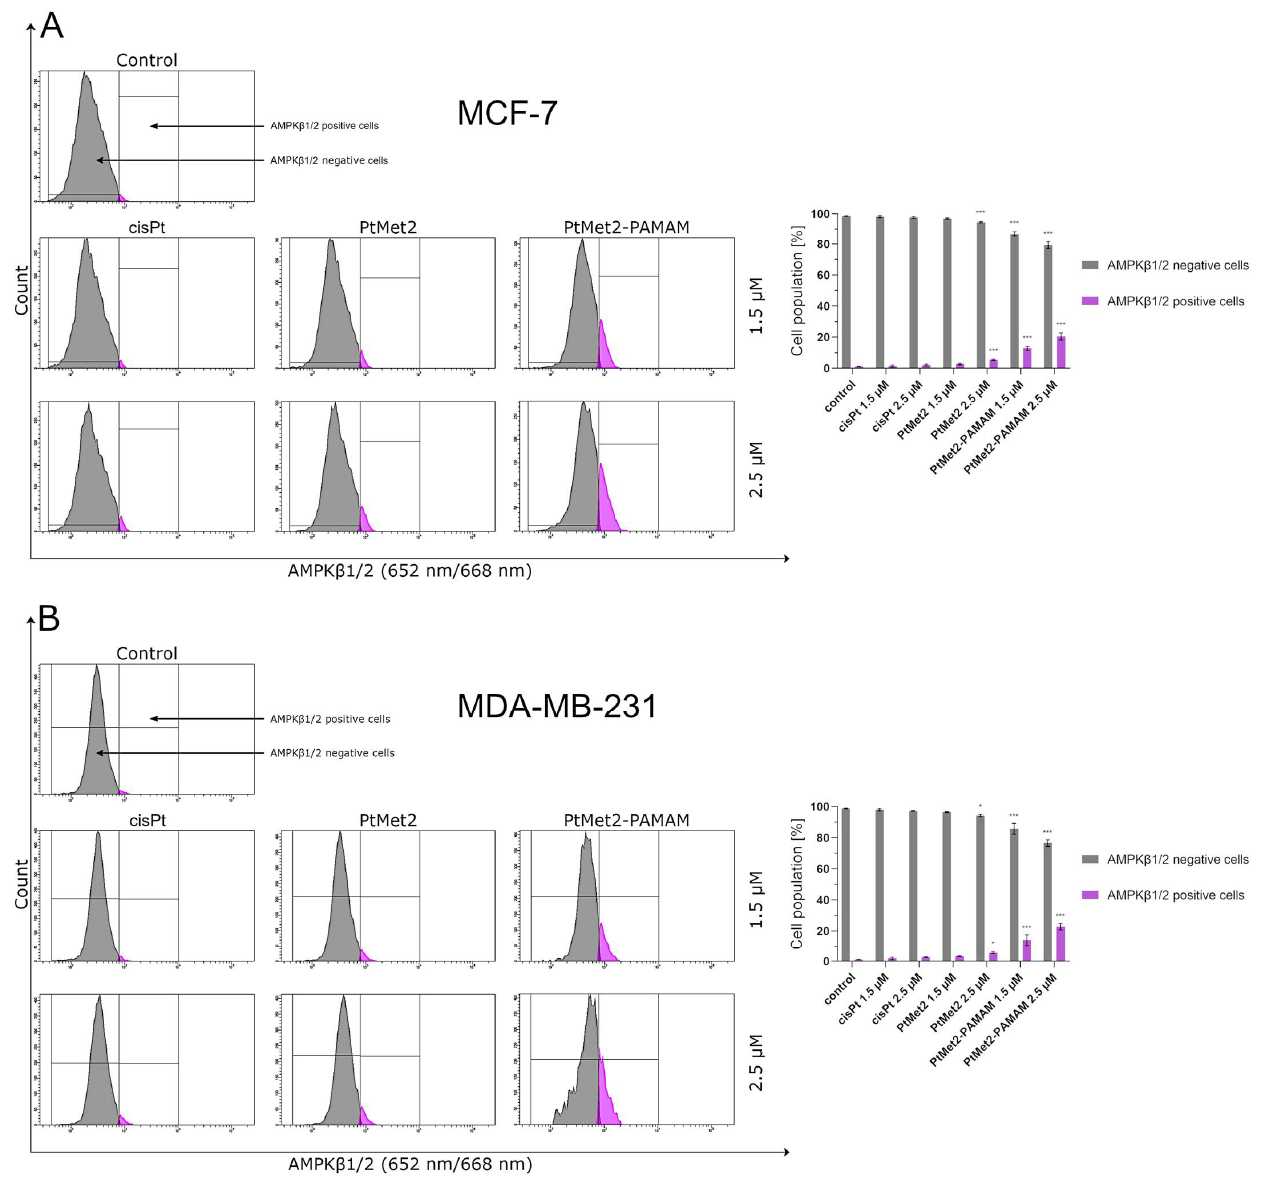
Figure 12. Anti-AMPKβ1/2 antibody flow cytometric analysis of MCF-7 ( A ) and MDA-MB-231 breast cancer cells ( B ) (right histogram—purple color) compared to a negative control cell (left histogram—gray color) after 24 h of incubation with PtMet2, PtMet2–PAMAM, and cisplatin (1.5 μM and 2.5 μM). Mean percentage values from three independent experiments ( n = 3) done in duplicate are presented. * p < 0.05 vs. control group, *** p < 0.001 vs. control group.